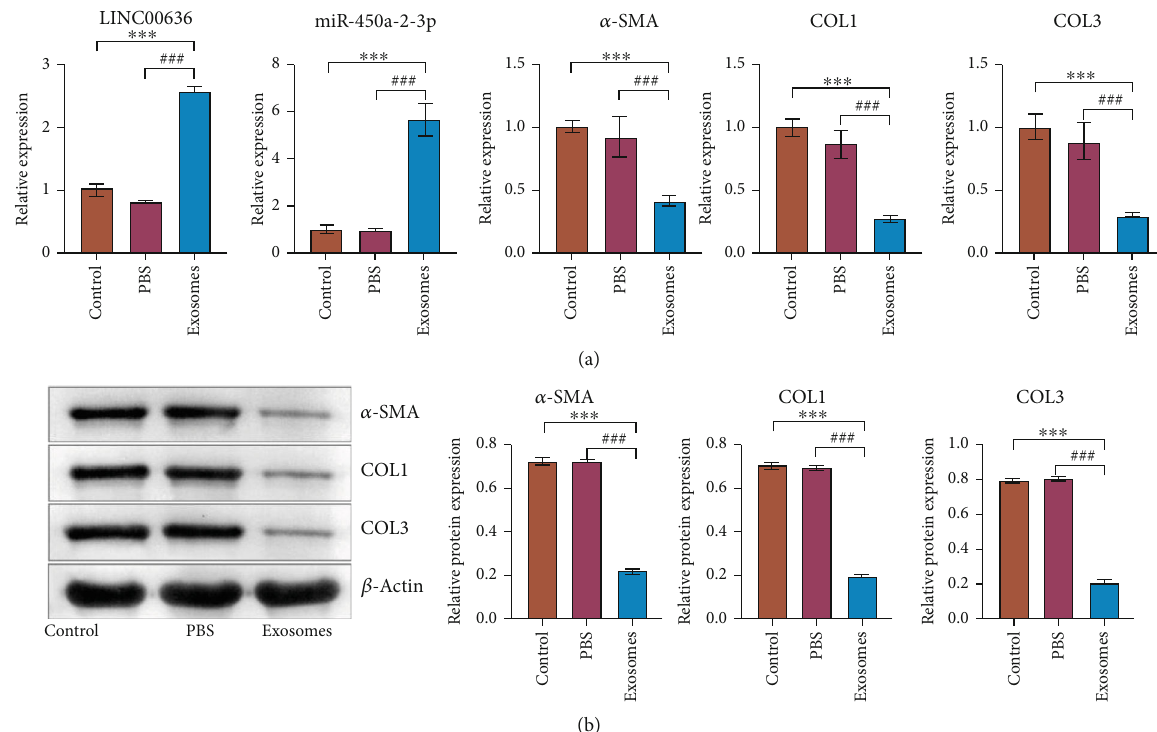
Figure 4: Exosomes containing LINC00636 could regulate miR-450a-2-3p and a ff ects CFs. (a) Gene expression levels were detected by RT- qPCR. (b) α -SMA, COL1, and COL3 protein levels were detected by western blot. ∗∗∗ indicates signi fi cant di ff erences with the control group, P < 0 : 001 ; ### indicates signi fi cant di ff erences with the PBS group, P < 0 : 001 .